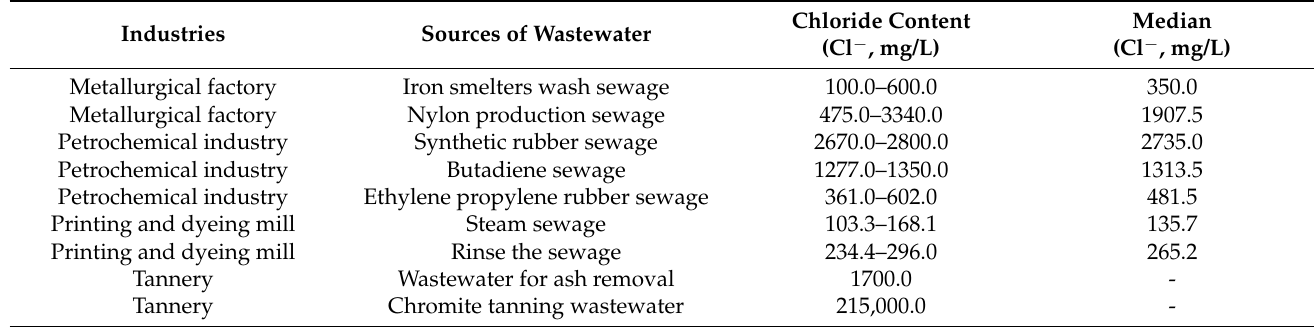
Table 1. The range of chloride content in wastewater discharged by certain industries.